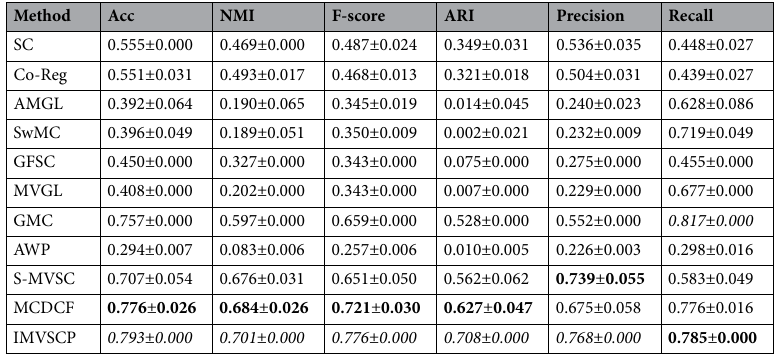
Table 7. Experimental results (mean standard deviation) on the 3-sources dataset. Significant values are in